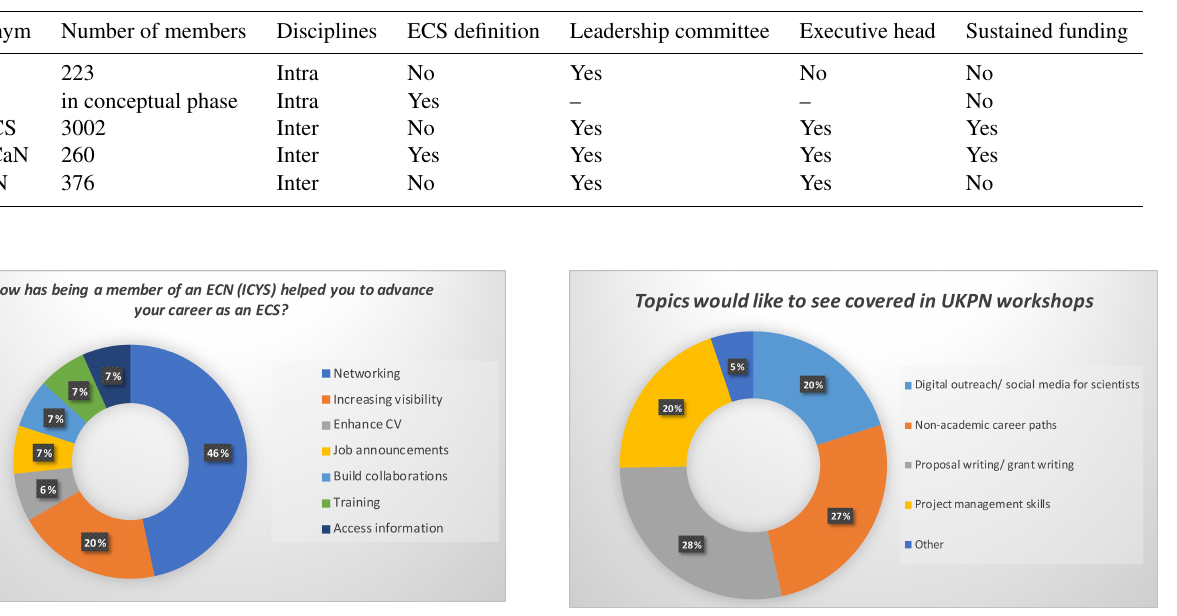
Figure 5. Survey results on what UK Polar Network members would like to see covered in